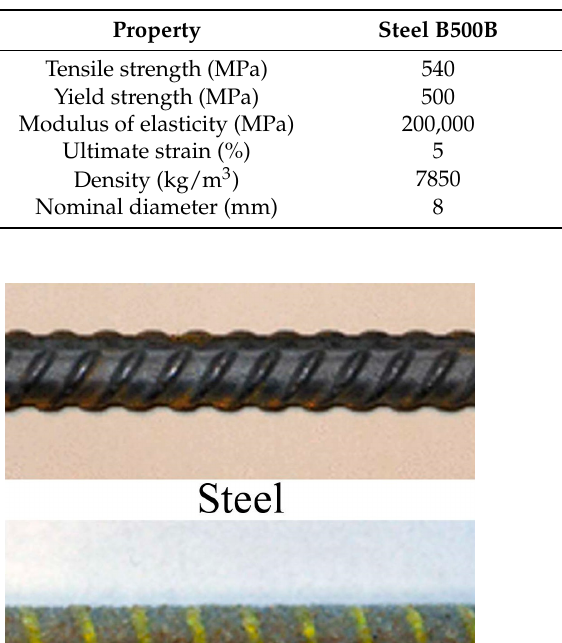
Table 3. Properties of reinforcement bars.